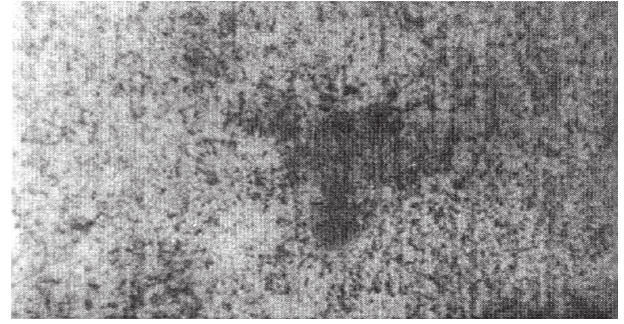
Figure 7. Micrograph of welded sample subjected to voltage V processing (×100).